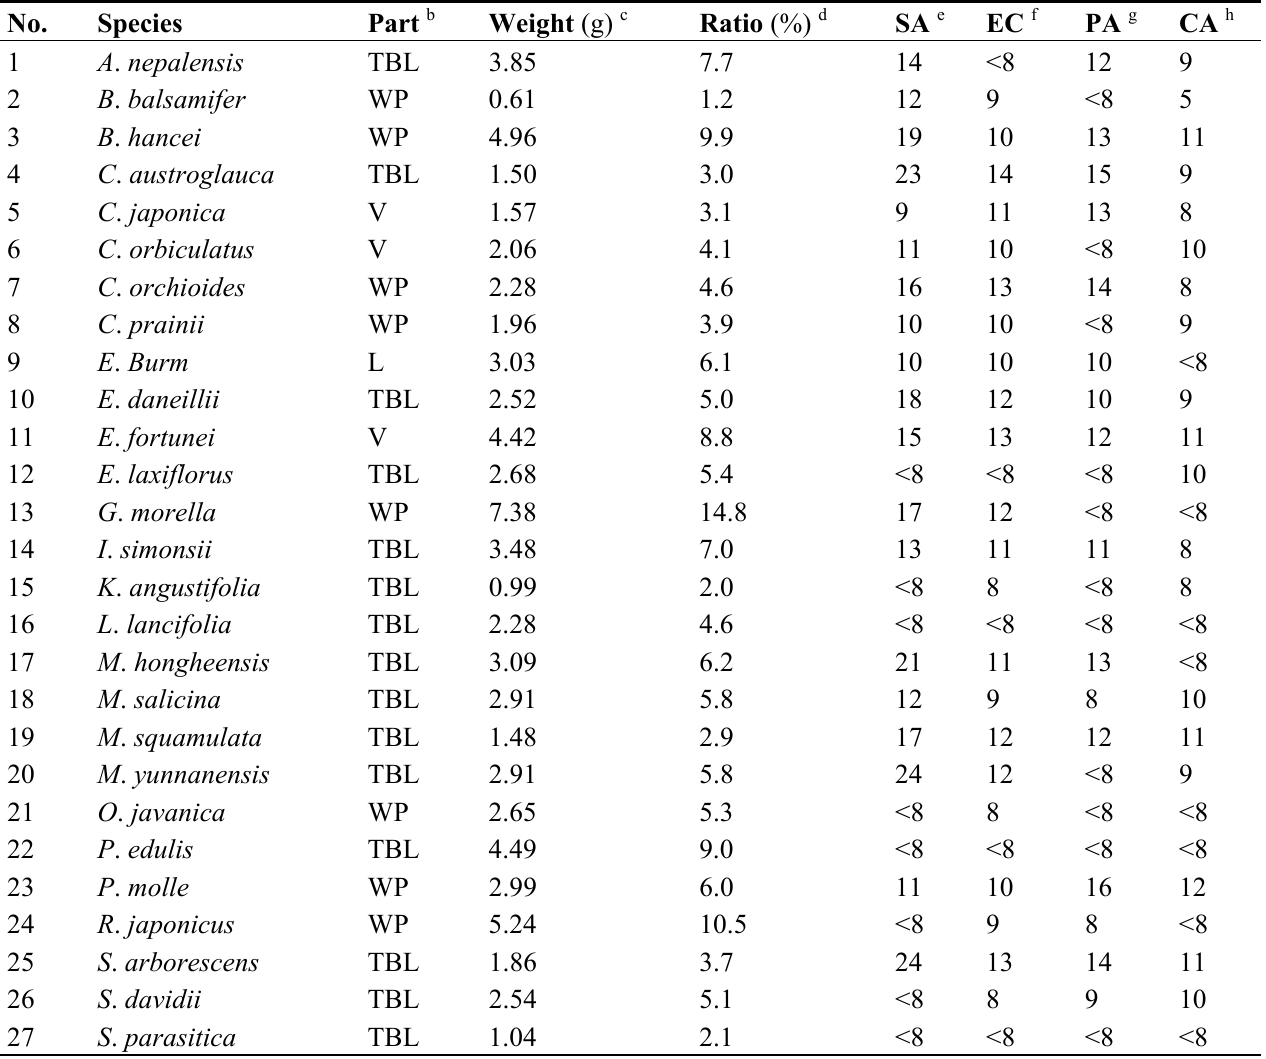
Table 3. Screening results of the antimicrobial activities of the extracts from 30 Chinese medicinal plants (IZD: mm) a